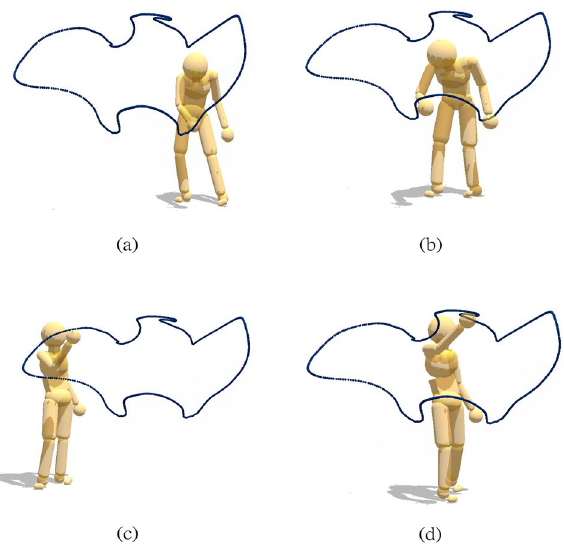
Figure 11. Model capability illustration. Four points in a tracing sequence reproduced with physics-engine- based inverse dynamics using recorded motion capture data from a human